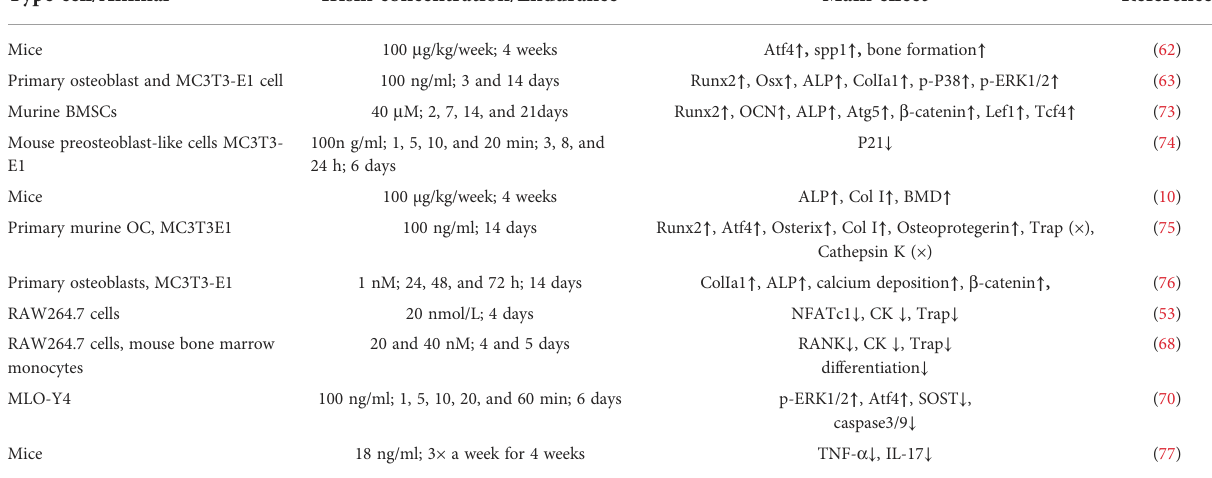
TABLE 1 Role of irisin in